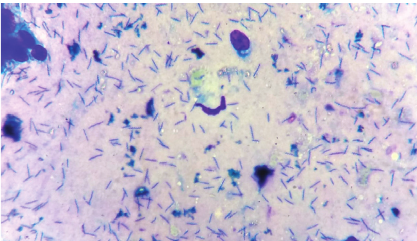
Figure 1: Impression smear of the gastric biopsy sample showing the presence of numerous Helicobacter organisms (Quick panoptic stain, ×